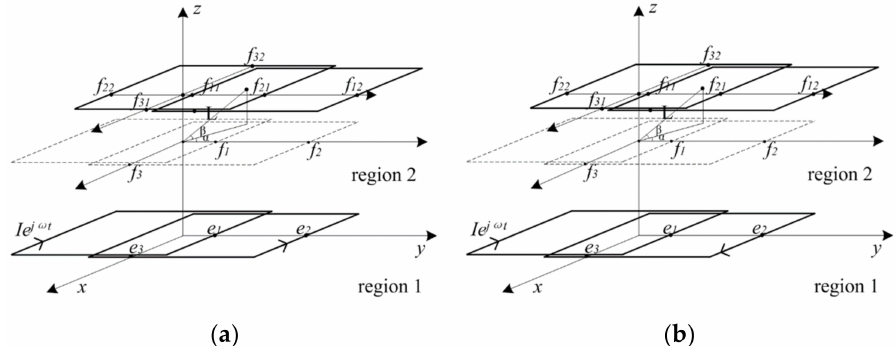
Figure 2. Layout of the dual Bipolar (BPP-BPP) filamentary coupler under misalignment. ( a ) Driven by the opposite phase currents; ( b ) Driven by the in-phase